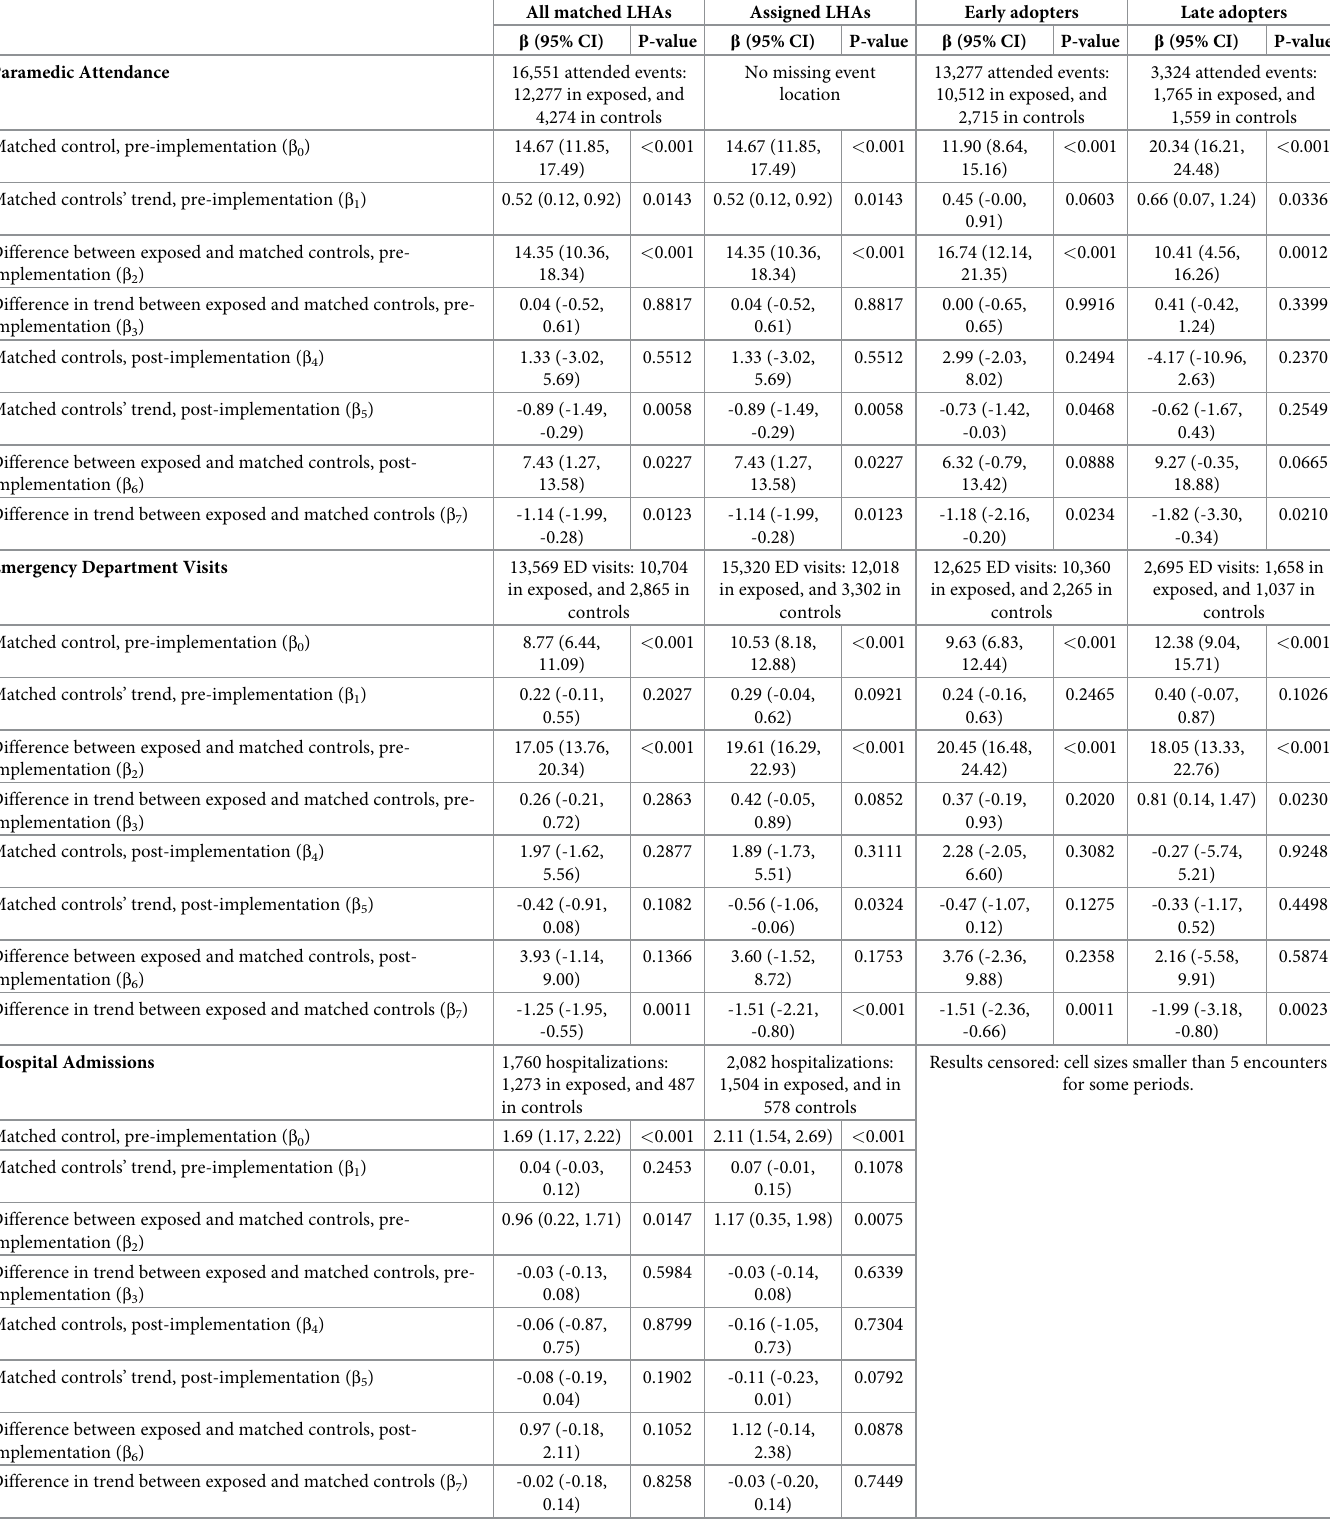
Table 3. Interrupted time series for exposed and propensity score matched controls. All output is reported per 100,000 population. All matched